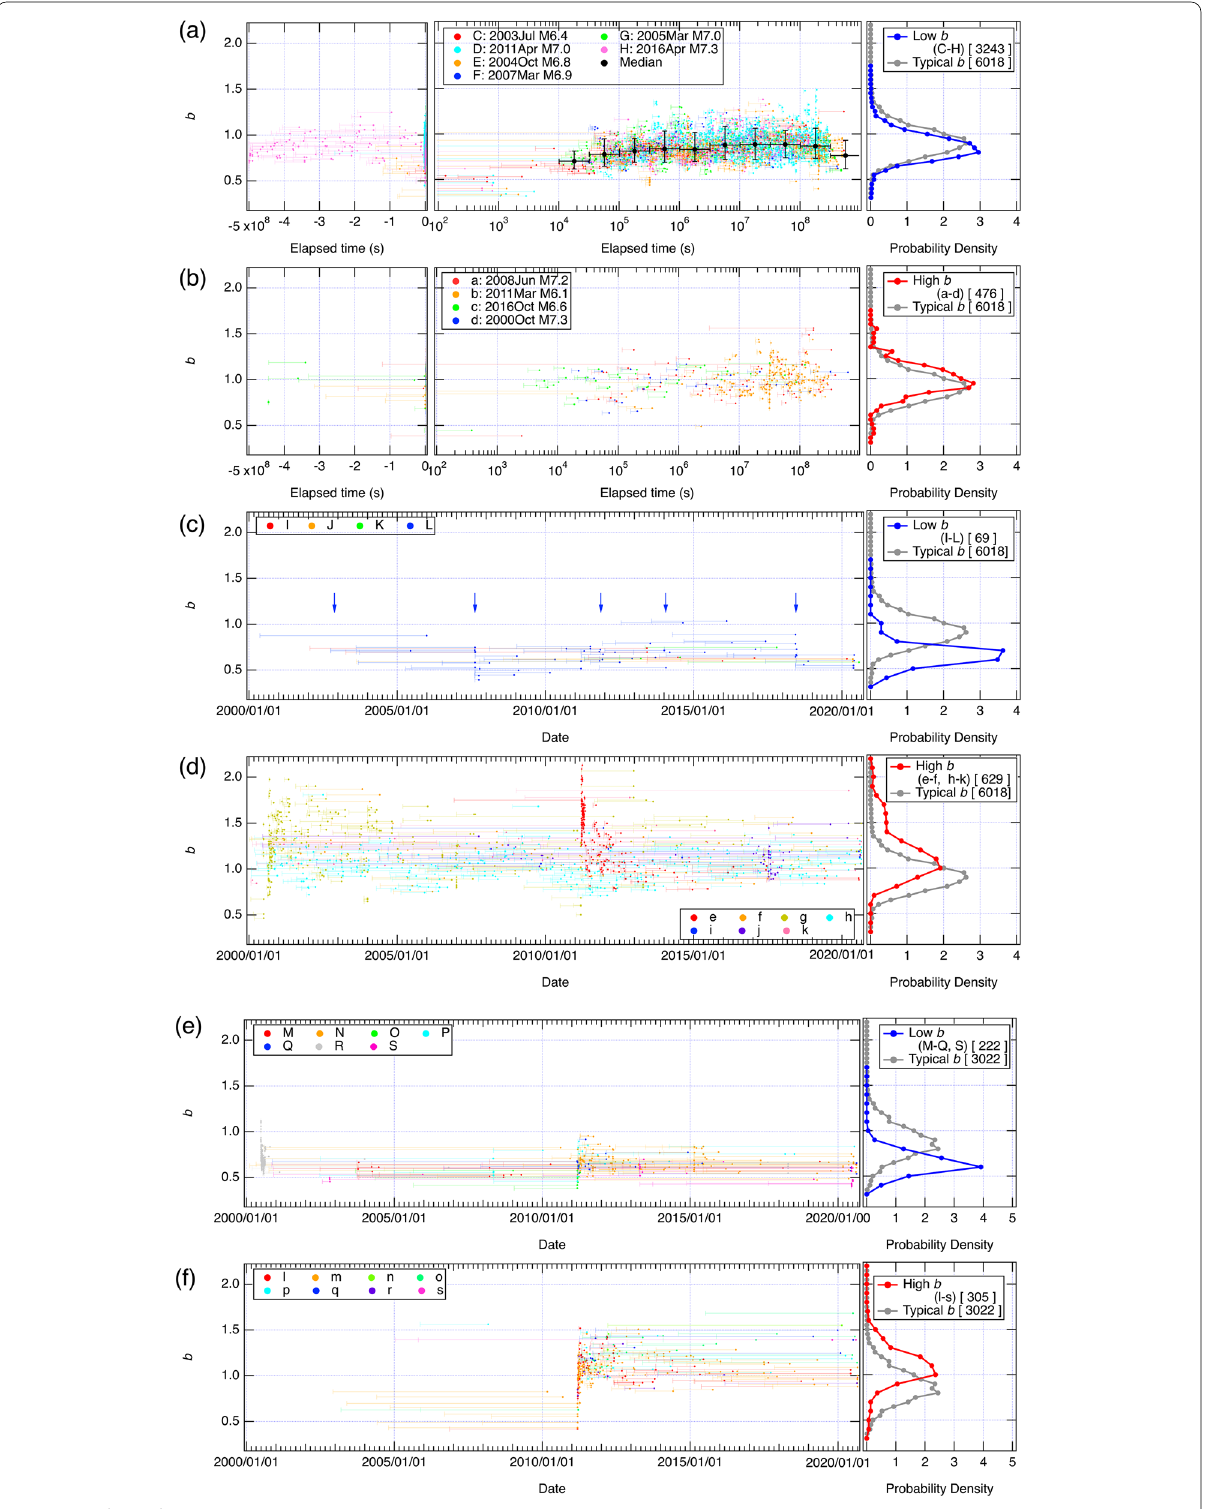
Fig. 9 (See legend on previous